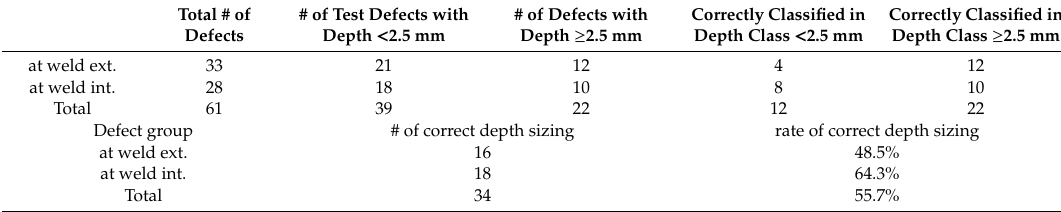
Table 3. Depth sizing accuracy of defects at weld.